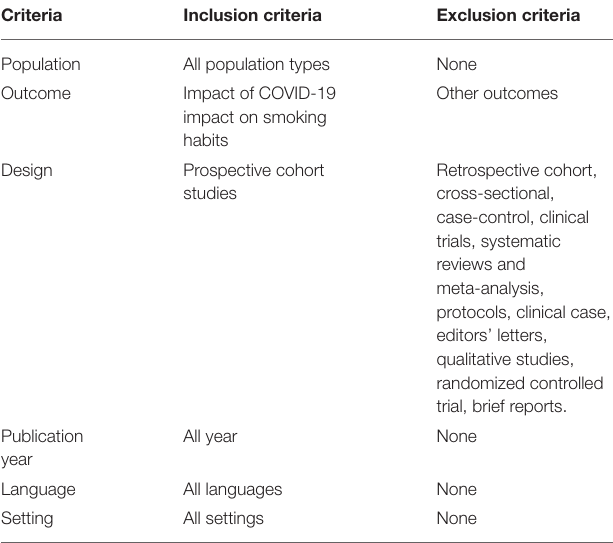
TABLE 1 | Inclusion and exclusion